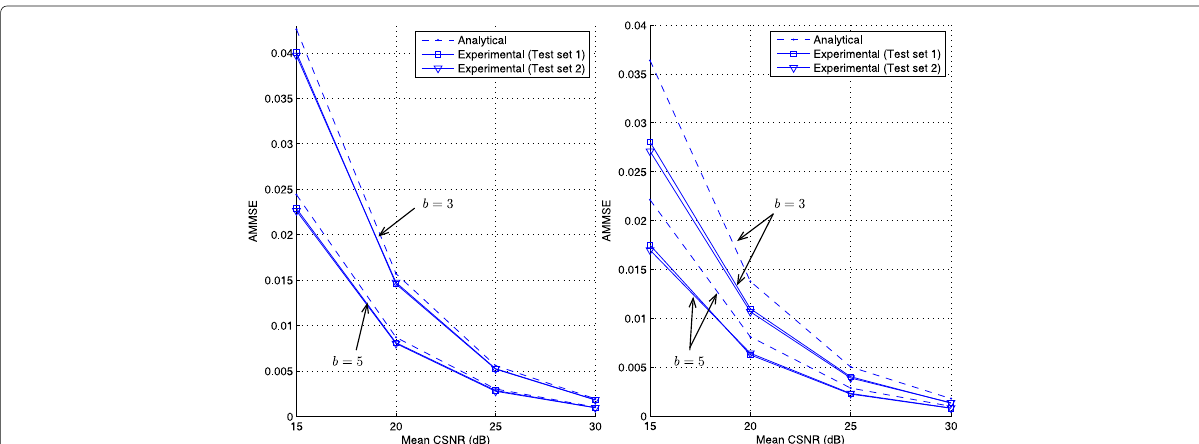
Fig. 6 A comparison of analytical and experimental AMMSEs of HDA systems designed for unit-variance speech signals, HDA-PQ ( left ) and HDA-TC ( right ). ρ and θ o values for HDA-PQ and HDA-TC systems shown here are listed in Table 4. Both HDA-PQ prediction order and HDA-TQ transform block size are 10